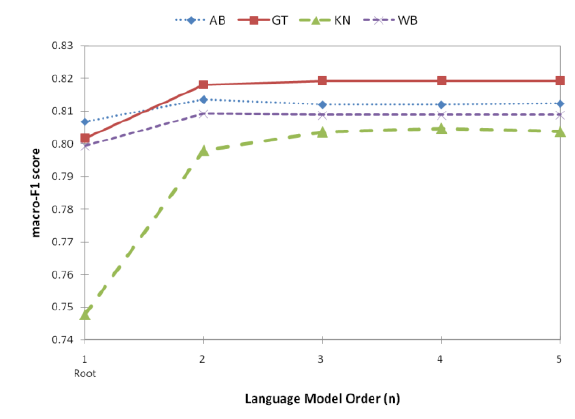
Fig. 4. Performance of root + POS tag based language models with different smoothing methods with respect to language model order